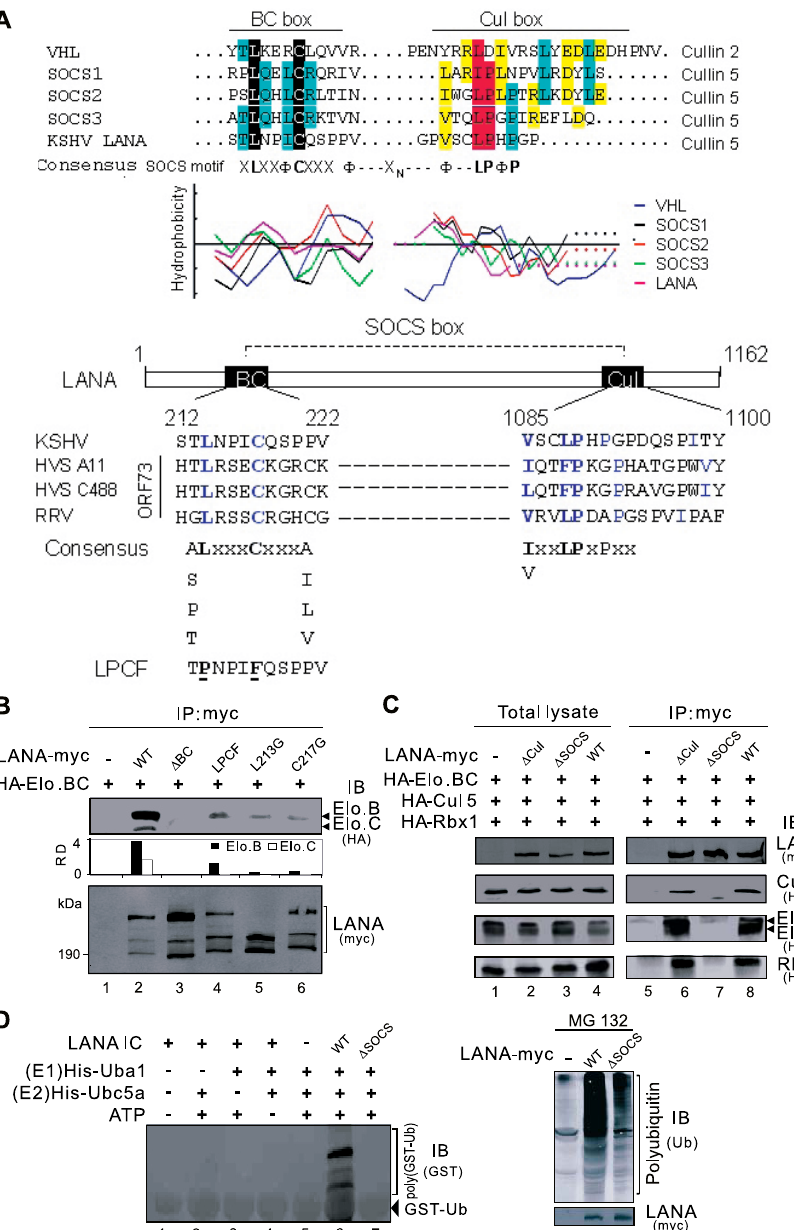
Figure 3. LANA Associates with the Elongin BC Complex and Cul5 through the SOCS-Box–Like Motif (A) KSHV LANA contains a putative SOCS-box motif which includes a consensus of BC-box and Cul-box motifs. Upper panels show hydrophobic sequence alignment of the BC-box and Cul-box motifs from viral LANA and cellular SOCS-box–containing proteins that bind Elongin BC and Cullin proteins individually. Conserved residues with similarity are shaded in the upper panel. Lower panels show ORF73 proteins from other gammaherpesvirus contain an SOCS-box–like motif which is similar to KSHV LANA. HVS, herpesvirus saimiri; RRV, rhesus monkey rhadinovirus. The site mutations of LANA in leucine (L) and/or cystine (C) are indicated with underlining. (B) LANA associates with the Elongin BC complex through the BC-box motif. Saos-2 cells were transfected with expression vector encoding the indicated proteins. The WT LANA and its mutant with BC-box ( D BC) deletion and point mutation (LPCF, L213G or C217G) within BC box were compared. Since LANA lost its normally top bands (approximately 230 kDa) in the L213G mutant, another two lower bands of LANA (between 190 kDa and 230 kDa) were specifically present. The lysates underwent IP and IB assays as described previously. RD, relative density. (C) LANA associates with Cullin 5 through the Cul-box motif. Saos-2 cells were transfected with expression vector encoding the indicated proteins. The WT LANA with Cul-box ( D Cul) or SOCS-box ( D SCOS) deletion was compared. The lysates underwent IP and IB assays as described previously. Crude extracts (left panels) and immune complexes (right panels) are shown. (D) LANA assembles with Elongin BC complex and Cul5/Rbx1 module to reconstitute a multiprotein complex with E3 ubiquitin ligase activity. Left panel shows the LANA–Elongin BC–Cul5–Rbx1 complex had ubiquitin ligase activity. The cell lysates of WT LANA (Figure 3C, lane 4) or SOCS-box–like motif deletion mutant (Figure 3C, lane 3) as control was subjected to anti-myc immunoaffinity purification. The purified LANA immune complex (IC) was incubated with various combinations of Uba1 (E1), Ubc5a (E2), and GST-ubiquitin (GST-Ub) in the absence or presence of ATP, to assess its ability to stimulate ubiquitylation in vitro. The proteins were separated by SDS-PAGE and IB using anti-GST antibodies. Right panel shows SOCS-box–like motif deletion reduced the capacity of LANA to induce polyubiquitylation. Saos-2 cells were transfected with WT LANA or its SOCS mutant. After 24-h transfection, cells were treated with MG132 (0.5 l M) for 2 h. Lysates were subjected to IB against Ub or myc antibodies. DOI: 10.1371/journal.ppat.0020116.g003 PLoS Pathogens |